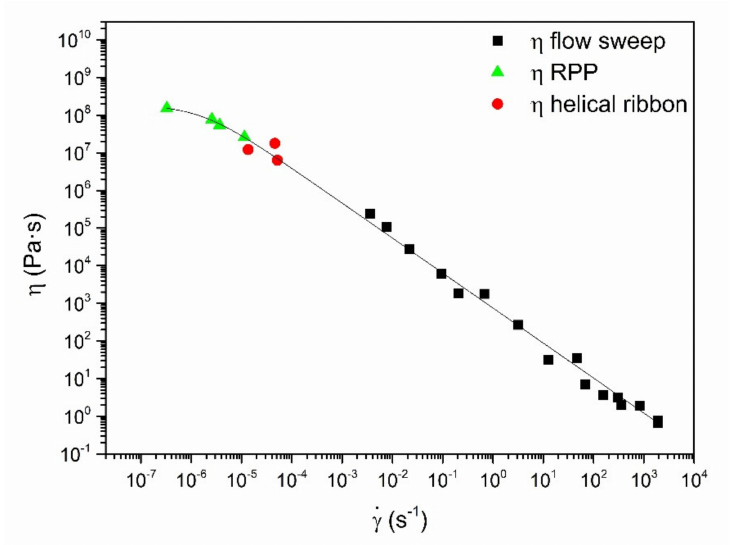
Figure 5. Viscous flow values for M200 sample including those obtained from compliance evaluation using both rough plate-plate (RPP) and helical ribbon geometries and those from viscous flow measurements (Cross model fit is also included).